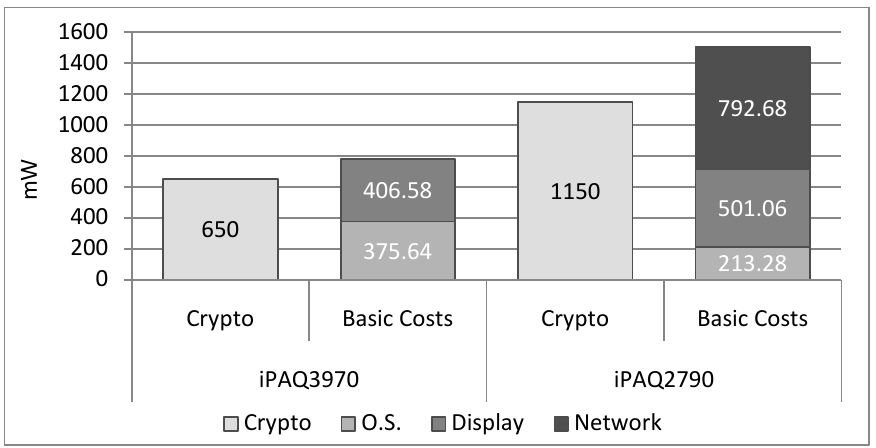
Figure 1. Average energy consumption (mW) of a